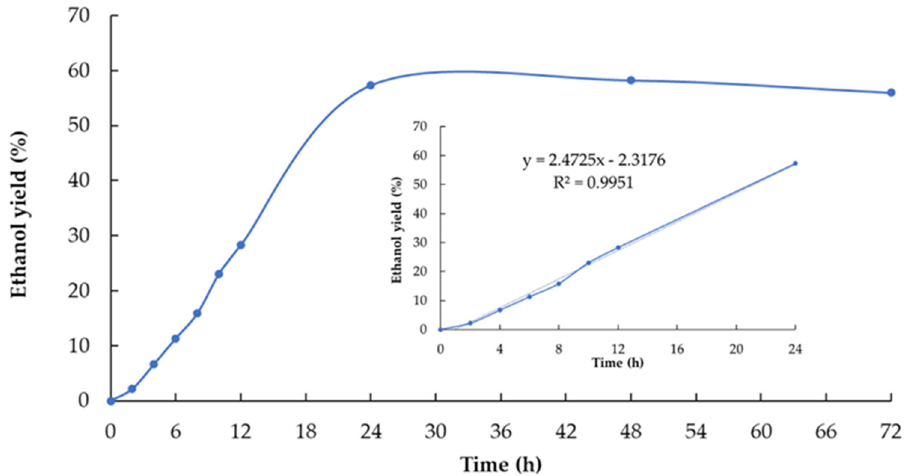
bioethanol at 42 ◦ C in 24 h, using SSB pretreated with base acid and saccharification at 50 ◦ C for 72 h. Thus, among the factors that can influence bioethanol yield are the type of reactor, load and enzymes blend in saccharification, initial availability of fermentable sugars, solids load, temperature, time, type of yeast, and raw material.